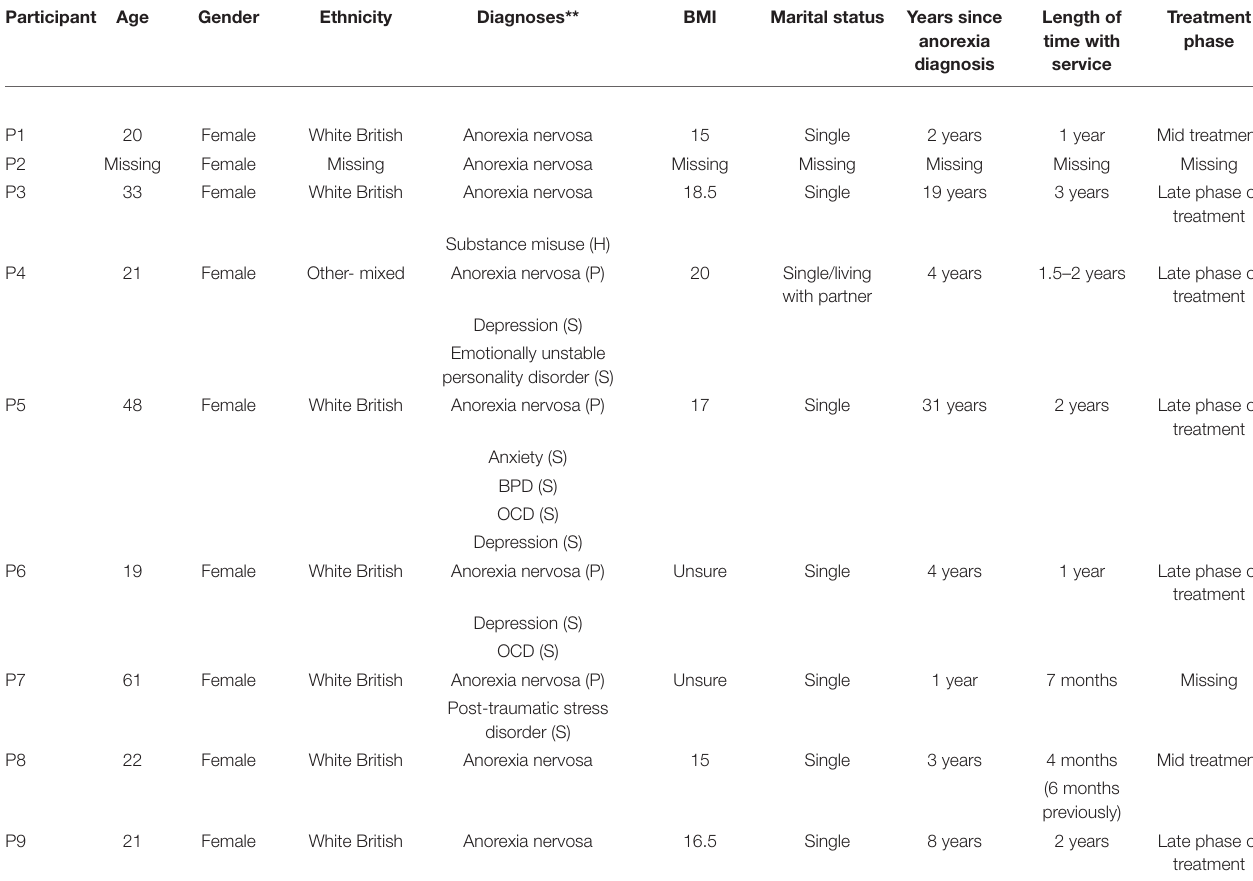
TABLE 1 | Participant demographic and clinical information. Participant